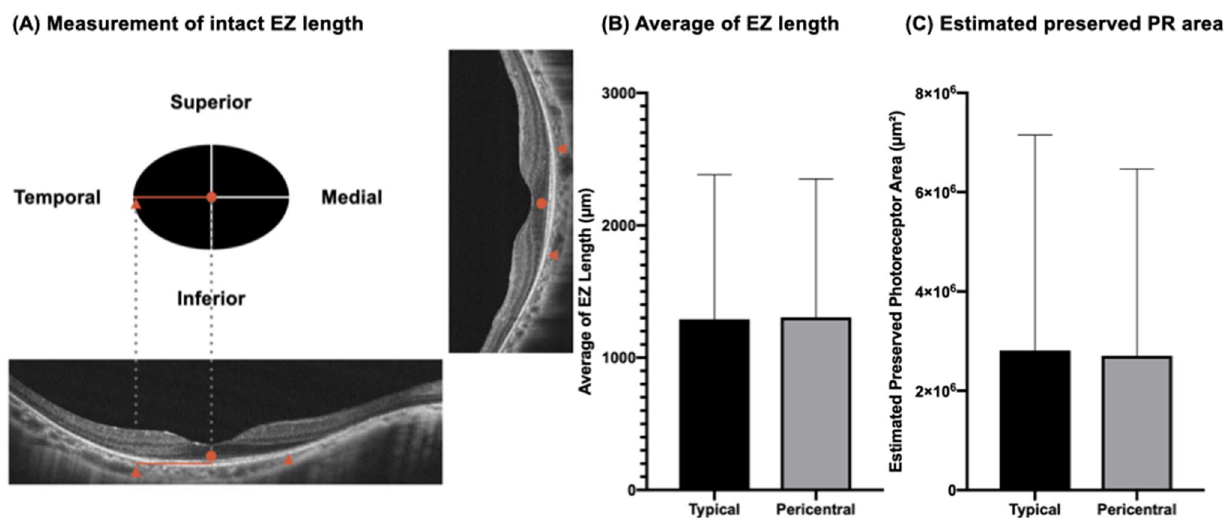
Figure 3. ( A ) Measurement of intact ellipsoid zone (EZ) length. The lengths of the intact EZ in four directions (nasal, temporal, superior, and inferior) were determined by measuring the distance from the center point to the end of the EZ in these directions. The estimated preserved photoreceptor area is calculated by the ellipse area formula (π x horizontal EZ length x longitudinal EZ length). ( B ) The average lengths of intact EZ were 1291.14 and 1305.18 µm in typical and pericentral types, respectively. ( C ) The estimated preserved photoreceptor areas were 2,814,352 µm 2 and 2,707,140 µm 2 in typical and pericentral types, respectively. * p < 0.05; ** p < 0.01 using unpaired